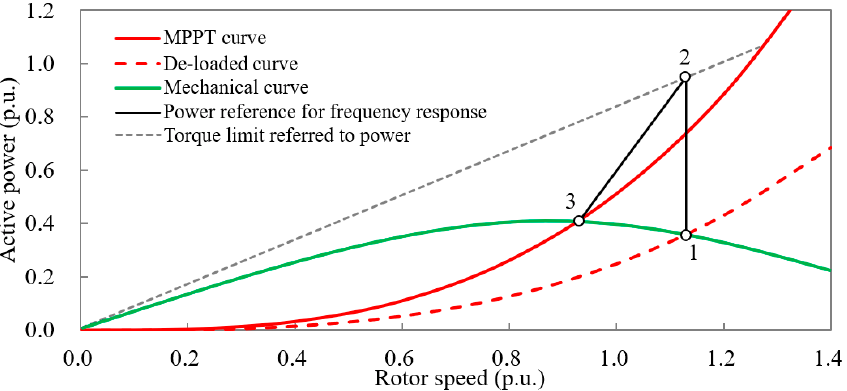
Figure 5. Power trajectory of the enhanced frequency response of the DFIG-based over-speed de-loaded curve.